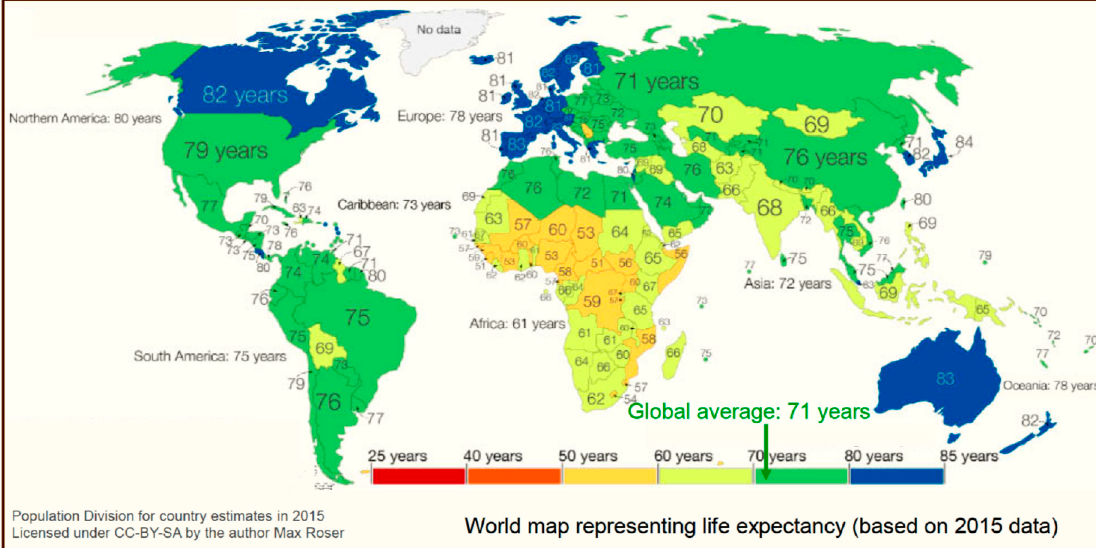
Figure 3. Diagram of the influence of various factors on Inequality-adjusted Human Development Index IHDI values.